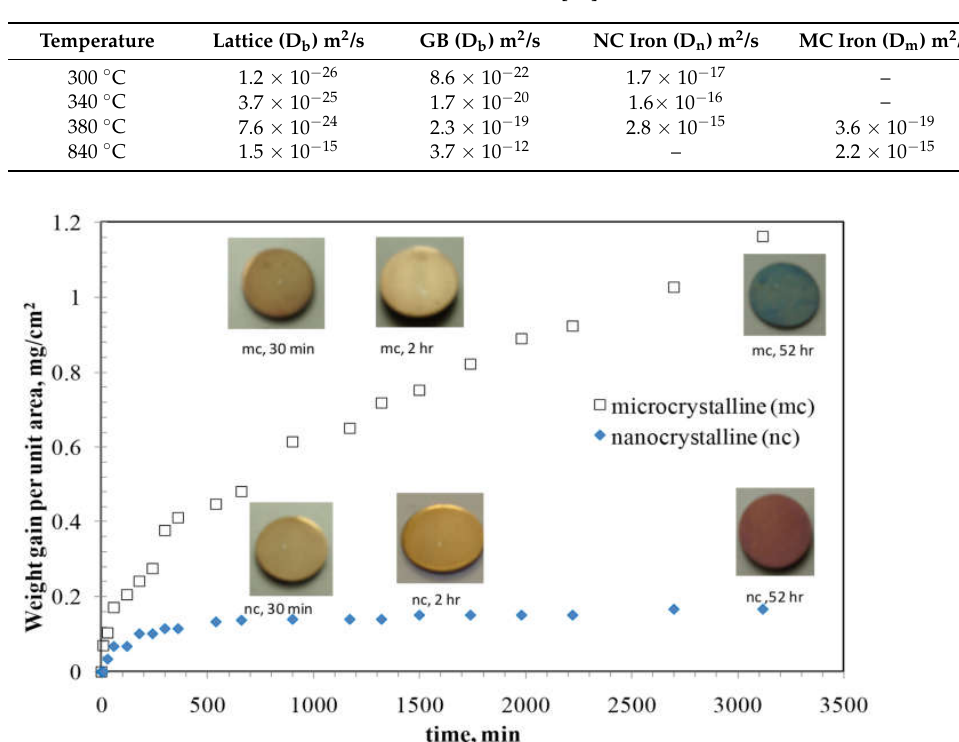
Figure 5. Oxidation kinetics (weight gain versus time plots) of Fe–10Cr alloy with nanocrystalline (nc) and microcrystalline (mc) structures oxidized at 300 °C for 3120 min (insets, show colour of the oxidized samples at different stages of oxidation) ([32], reproduced with copyright clearance).